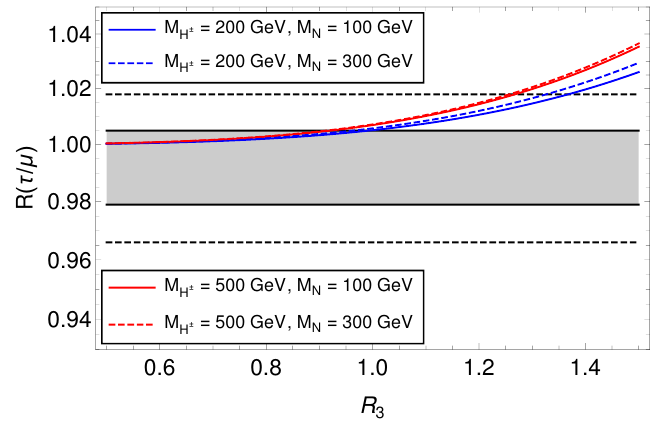
Figure 13 . Dependence of lepton flavour universality test ratio R ( τ/µ ) on parameter R 3 for different values of scalar and heavy neutrino masses as shown in the legends keeping Y 22 fixed at